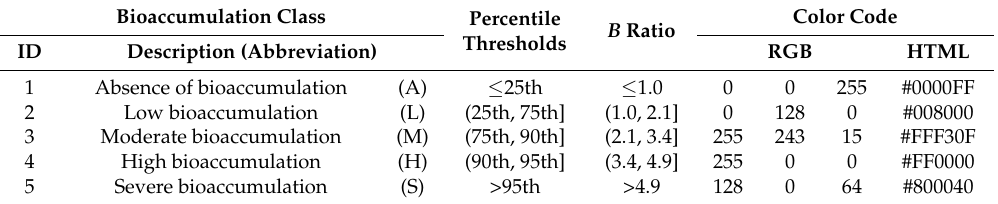
Table 4. B ratio, percentile-based, five-class interpretative scale for bioaccumulation data from native lichens. Class codes, description and abbreviations, percentile thresholds, corresponding B ratio values, RGB and HTML color codes associated to bioaccumulation classes are